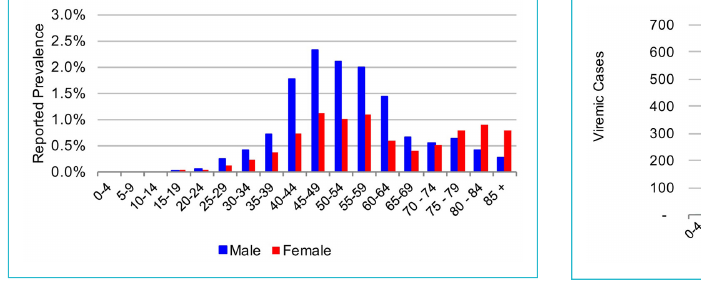
Figure 5: Distribution of hepatitis C cases by five year age cohort in the canton of Geneva in 2015.